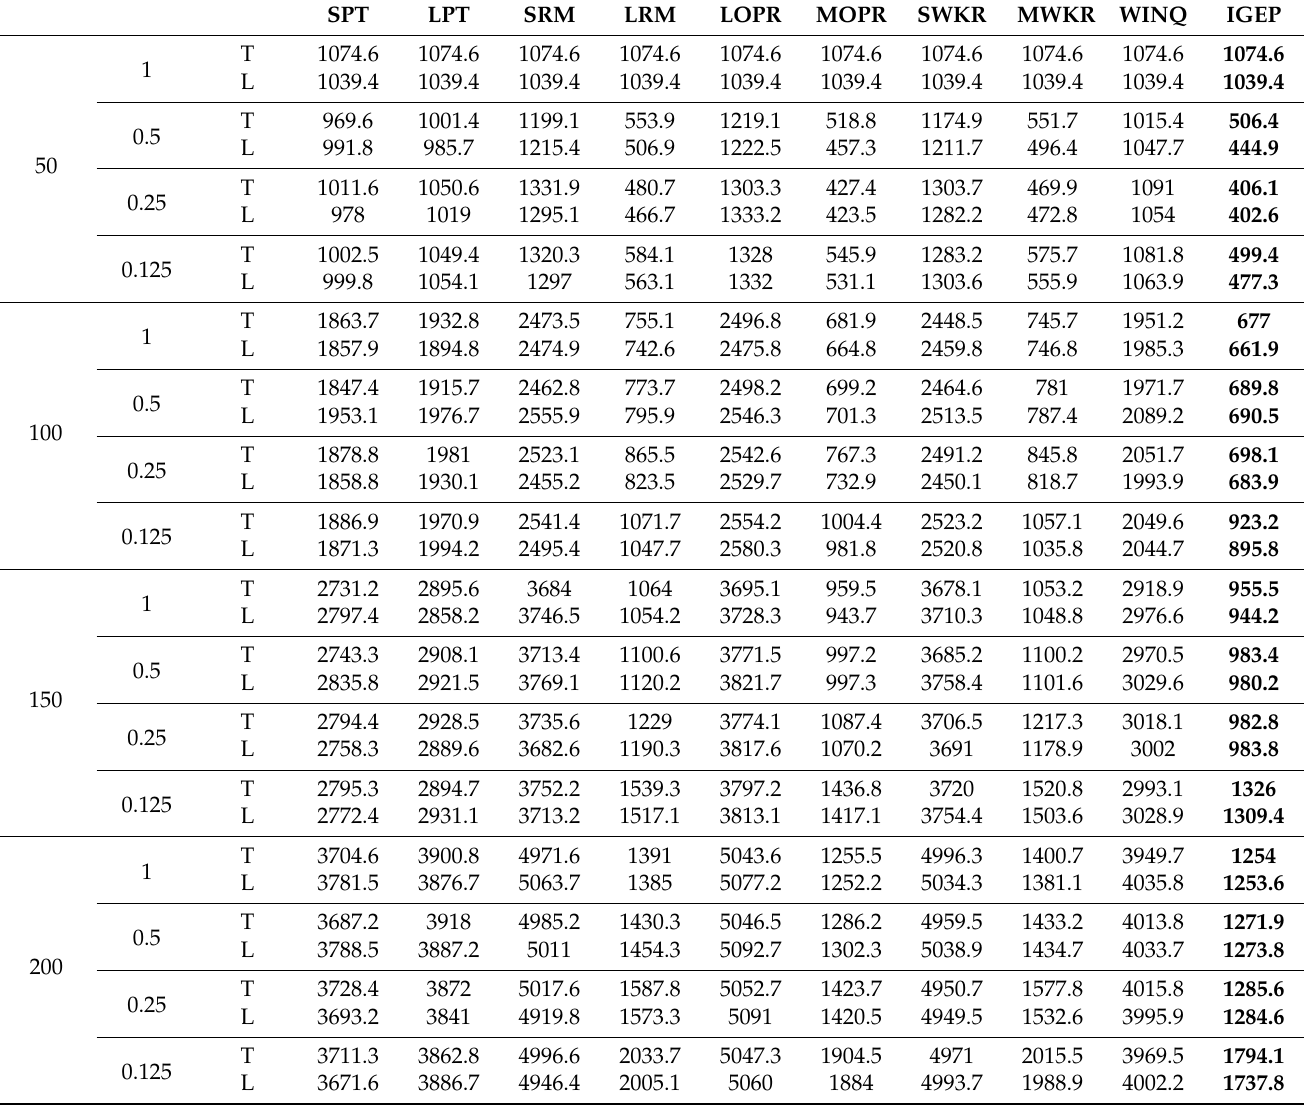
Table 4. Comparison of discovered/combination rules with minimum